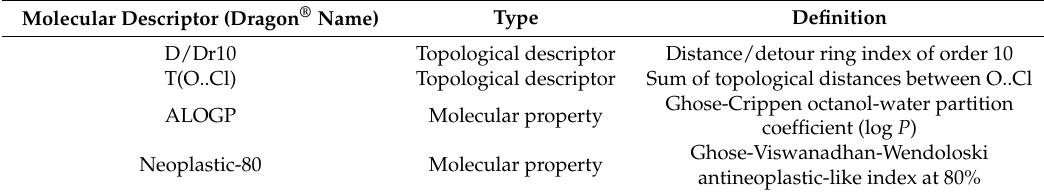
Table 2. Molecular descriptors in quantitative structure-activity relationship developed for prediction of skin permeability.